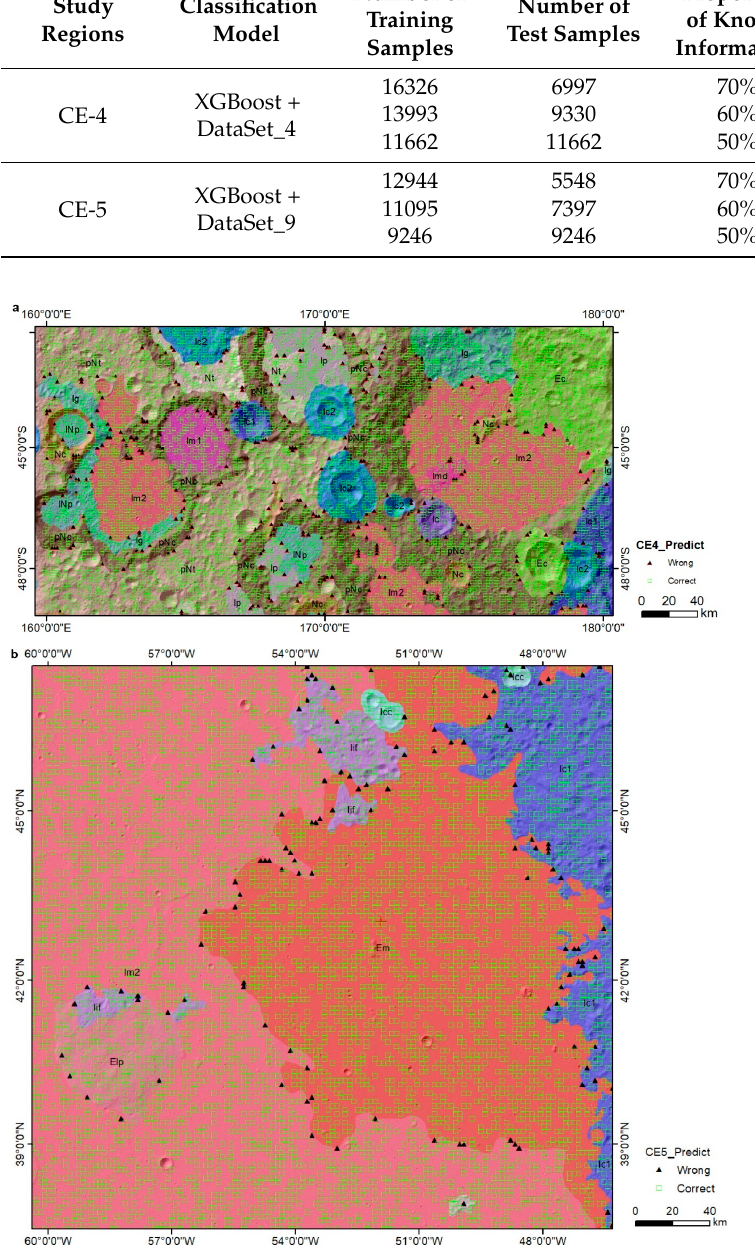
Figure 9. Visualization of classification prediction results of geological units for two study areas. ( a ) Chang’e-4 landing area. ( b ) Chang’e-5 landing area.